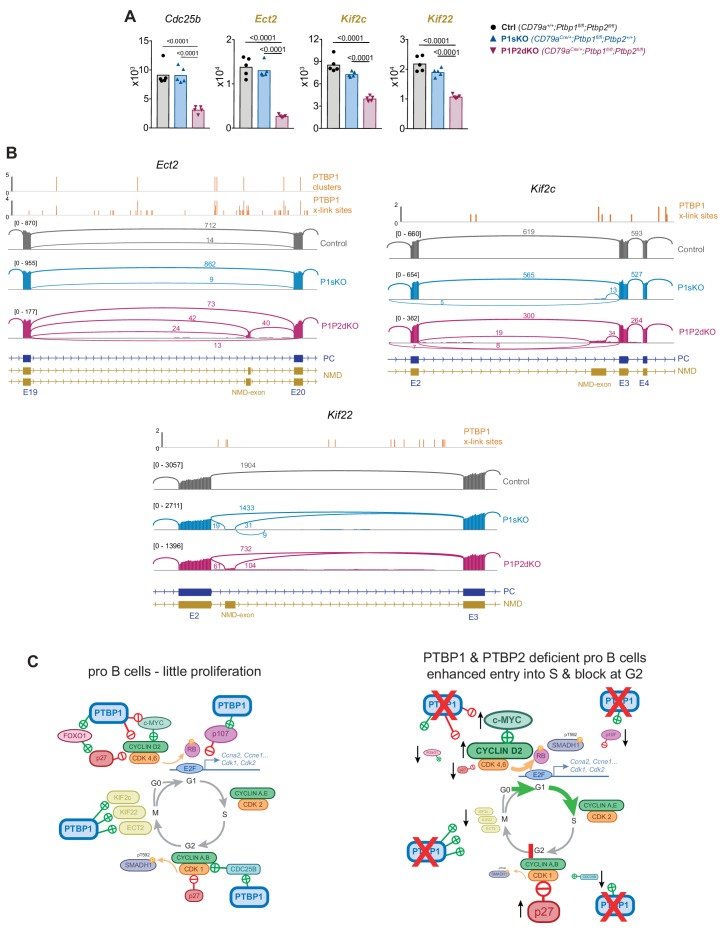
PTBP1 controls expression of genes important for mitosis.(A) mRNA abundance of the indicated genes. Genes whose names are in yellow and bold are predicted to have reduced mRNA abundance due to changes in AS triggering NMD upon Ptbp1 and Ptbp2 deletion. Individual data points show DESeq2 normalised read counts from individual pro-B cell mRNAseq libraries. Bars depict arithmetic means. DESeq2 calculated adjusted p-values are shown when < 0.05 for the indicated pairwise comparisons. (B) PTBP1 iCLIP and mRNA-Seq visualisation as described in Figure 8E. Ect2 has an additional isoform that appears with low numbers of reads which is not depicted in the gene model. This isoform results from the inclusion of an alternative 3’ splice site on Ect2 exon 20 which will generate in an isoform predicted to be degraded by NMD. (C) Representation of cell cycle mRNA regulon controlled by PTBP1 in pro-B cells and consequences of Ptbp1 and Ptbp2 deletion in pro-B cells. Depicted interactions of PTBP1 with individual factors are likely to be direct.